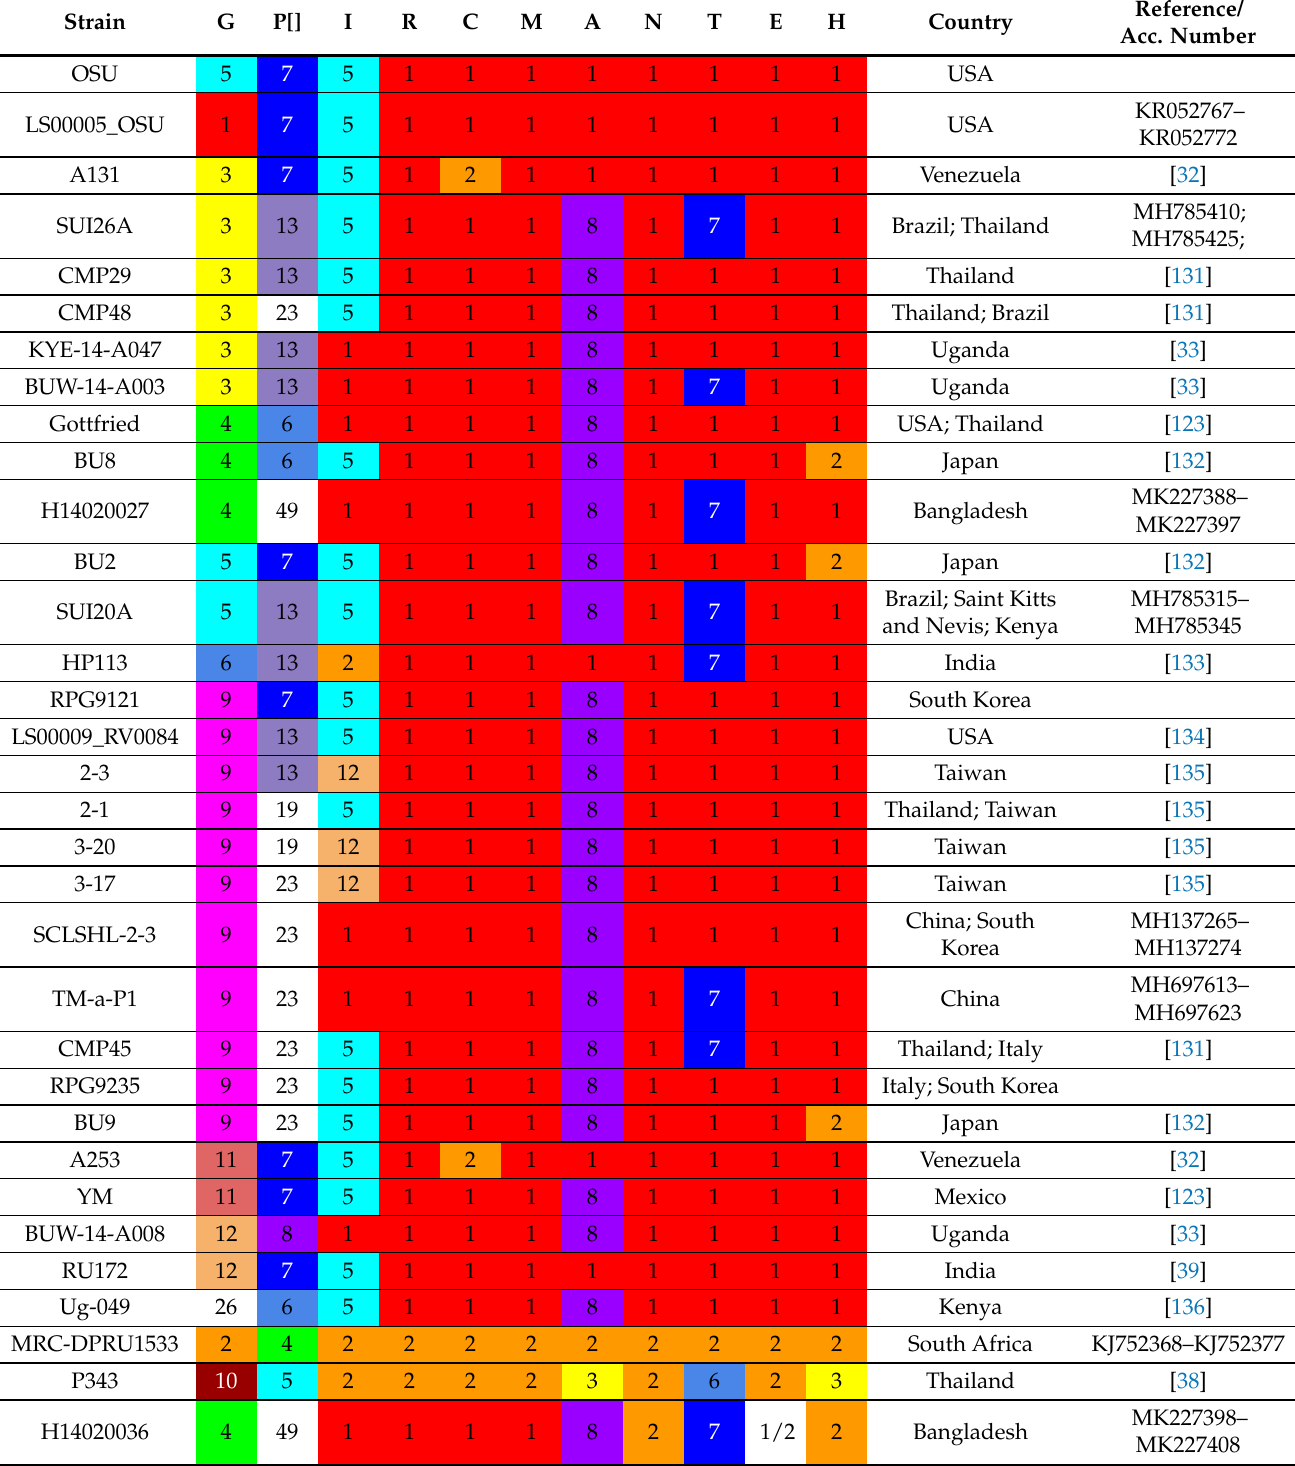
Table A4. Complete pig